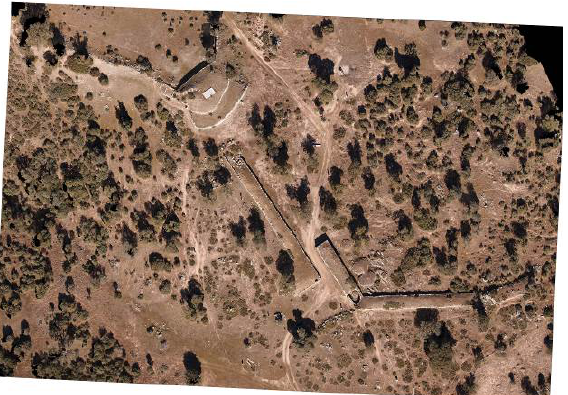
Figure 7. True orthophoto of the